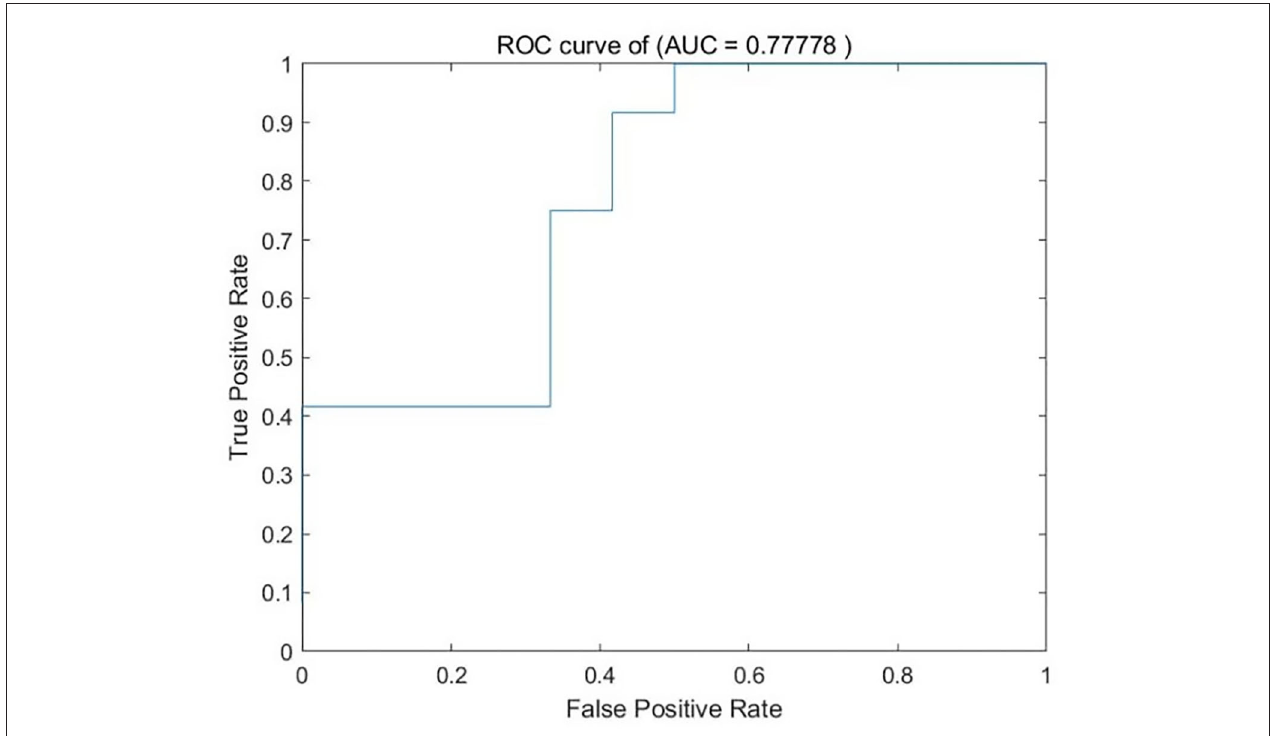
TABLE 3 | PreAF applied in ophthalmic and neurogenic diseases. Author Year Disease Brain areas